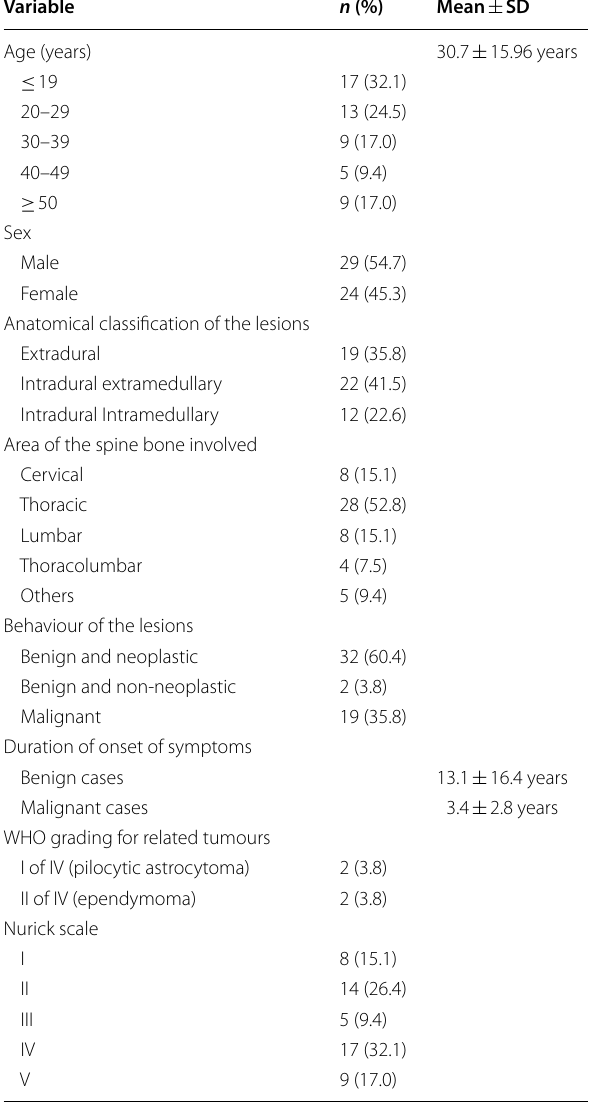
Table 1 Description of the characteristics of the patients Table 2 Clinical features of the patients at presentation ( N